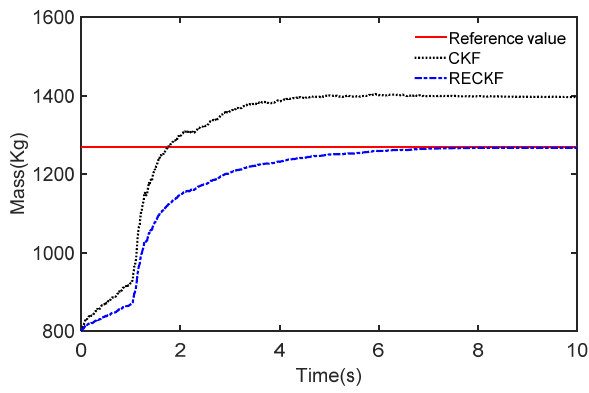
Figure 11. The tire forces in the case of deceleration.